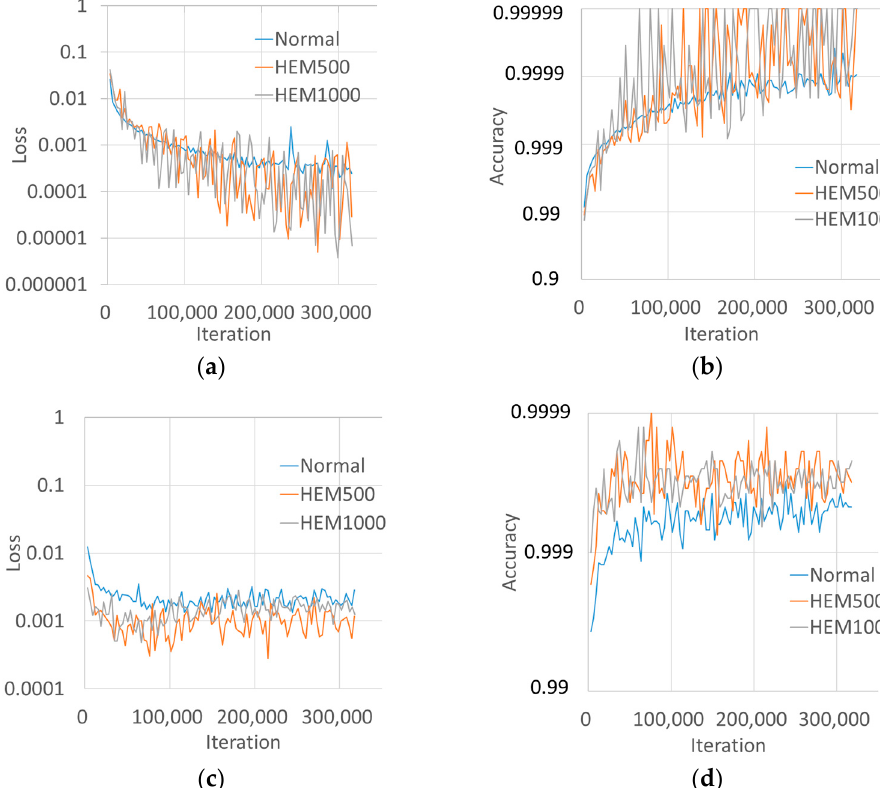
Figure 9. Training curve example. The background patch amount was ×200 in this case. ( a ) Training loss; ( b ) training Accuracy; ( c ) validation loss; and ( d ) validation accuracy.